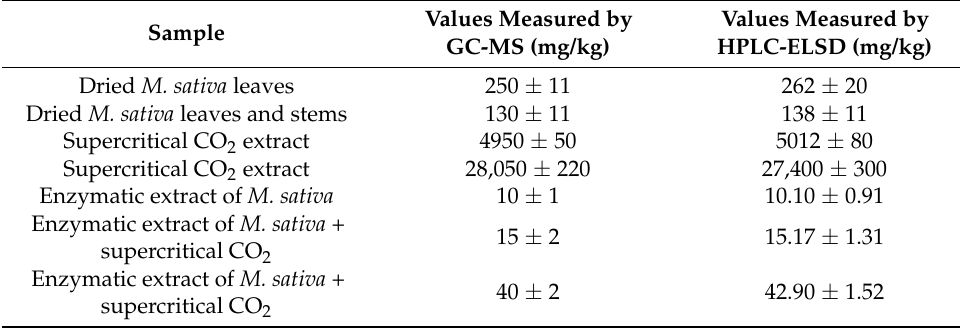
Table 4. Comparison of the amounts of TRIA revealed by GC-MS and by HPLC-ELSD. Values Measured Sample